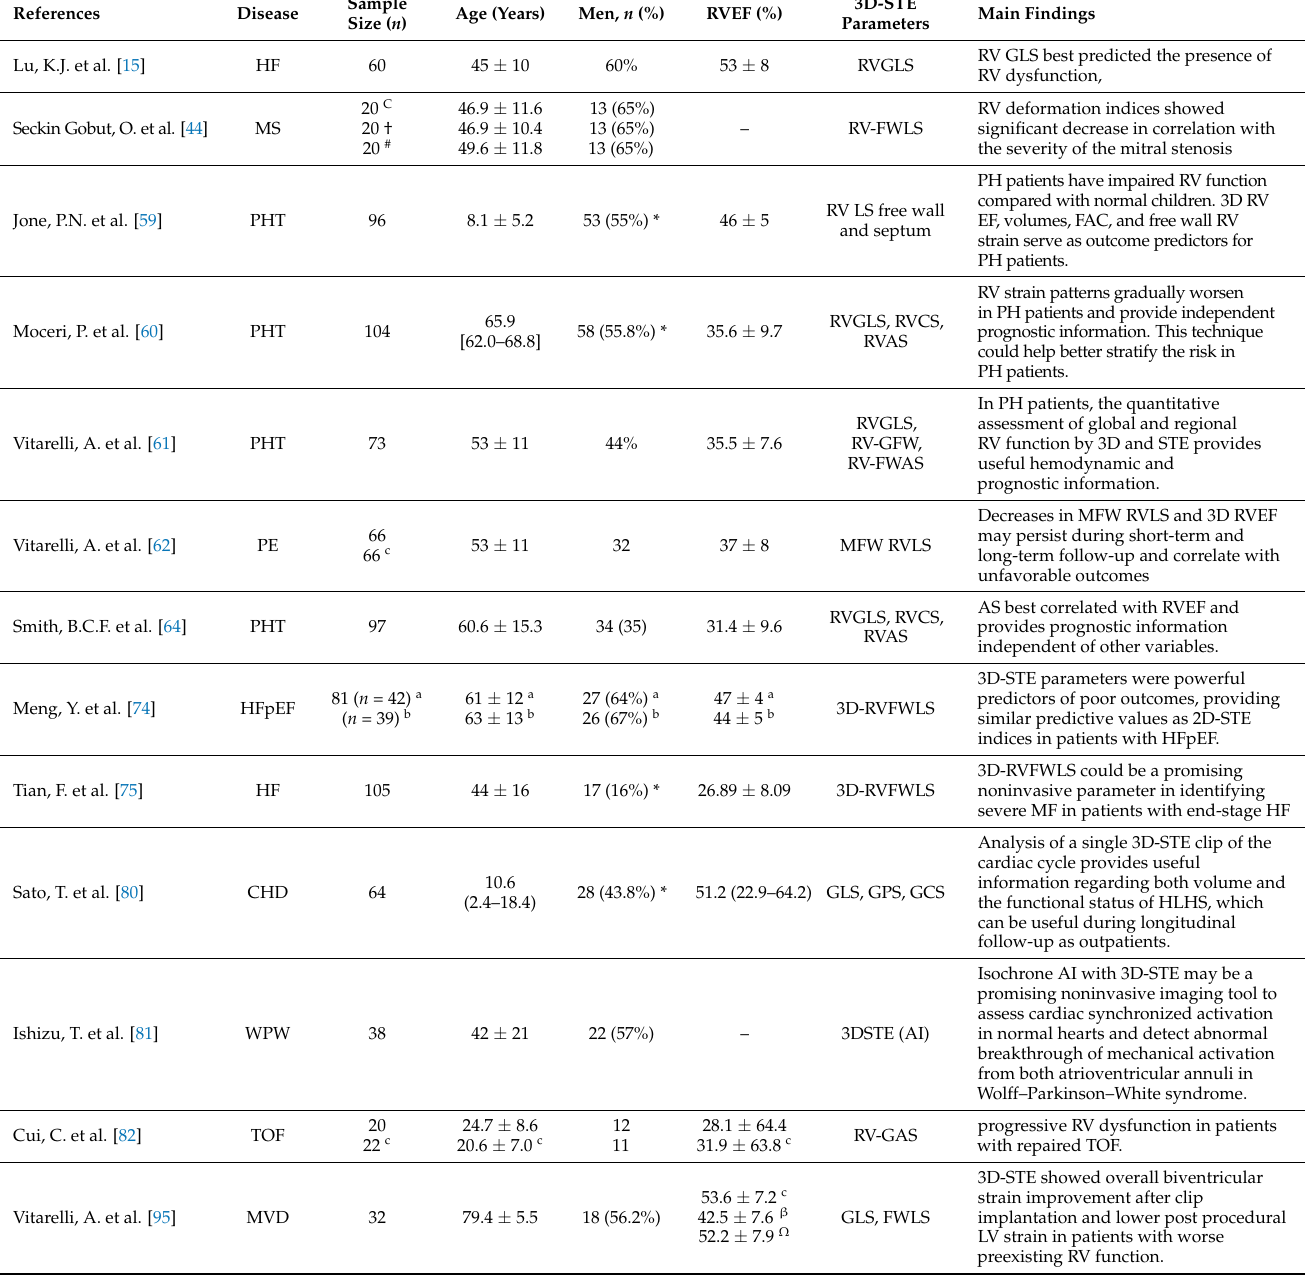
Table 2. Assessment of RV function in patients using